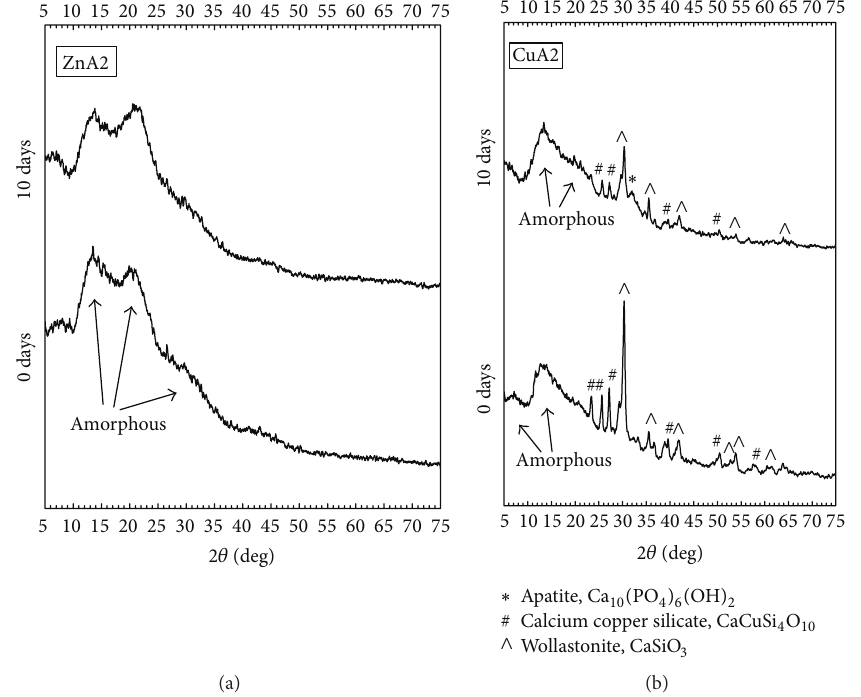
Figure 7: XRD spectra of (a) ZnA2 and (b) CuA2 glass-ceramic scaffolds before and after immersion in SBF solution for 10 days.